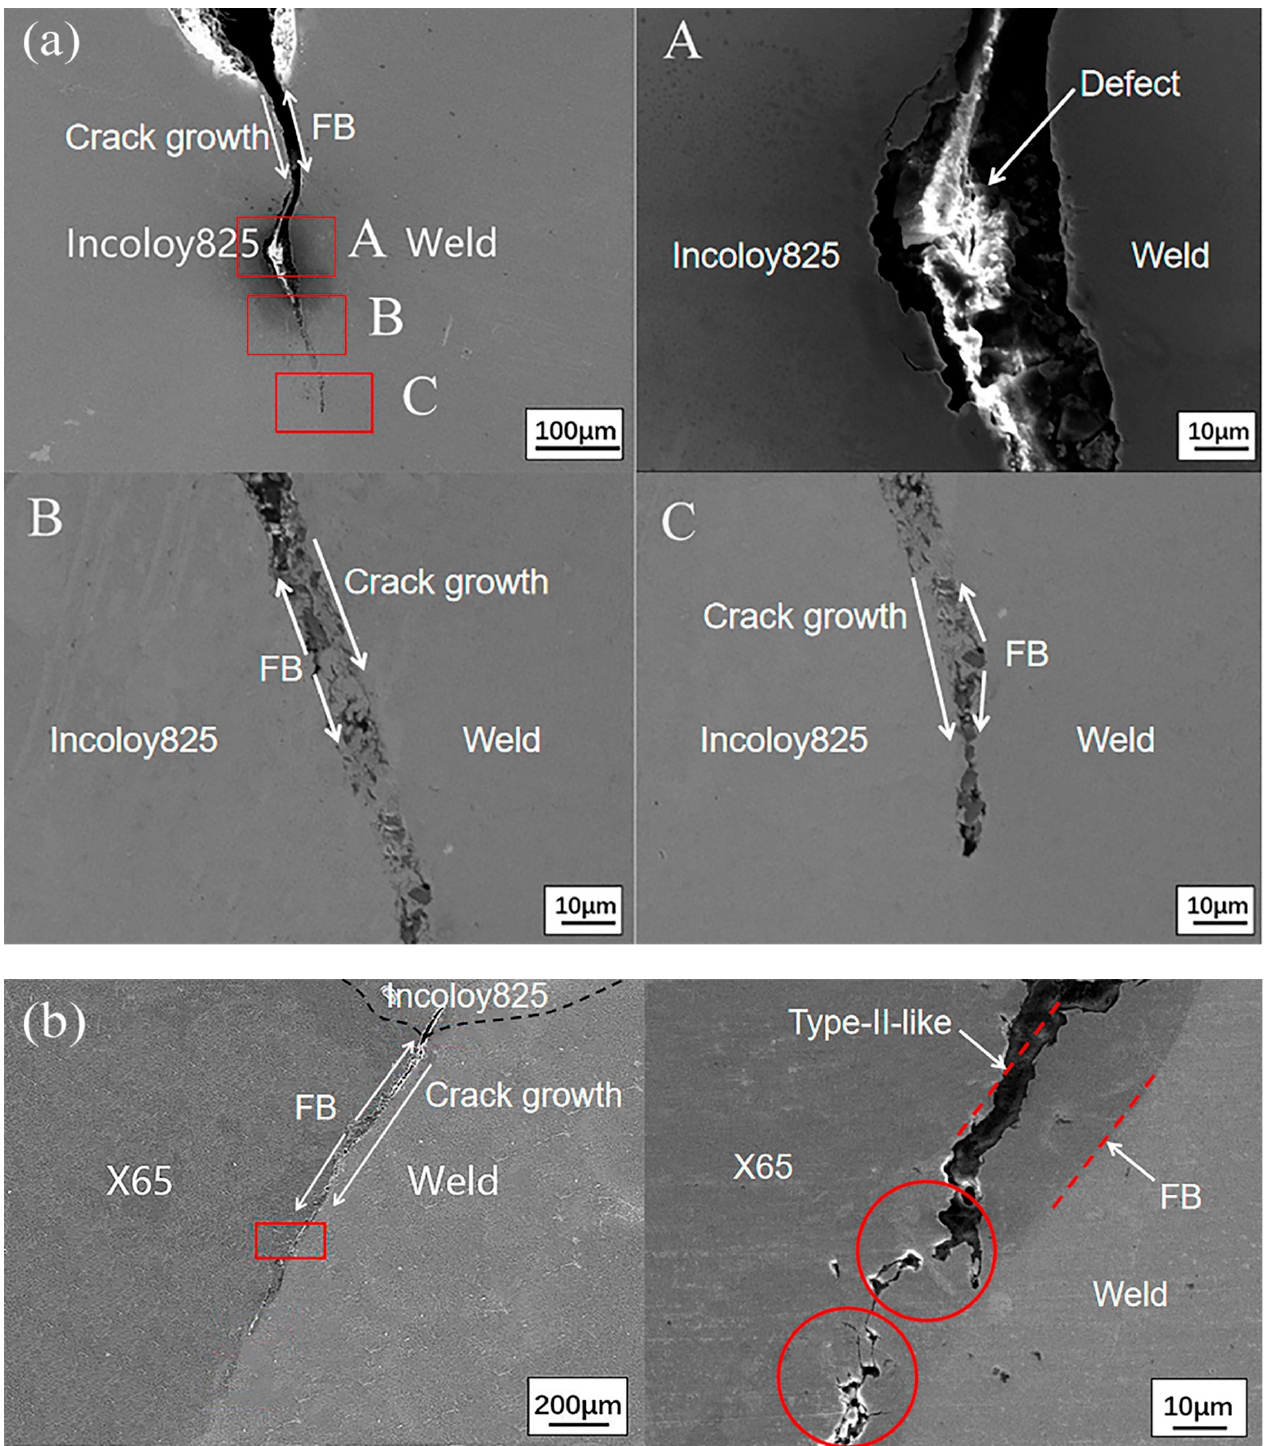
Figure 7. SEM diagram of crack 1 and crack 2: ( a ) overall view and local magnification (A–C) of crack 1; A–C diagram represent the local magnification of three places A, B and C, respectively; ( b ) overall view and local magnification of crack 2.